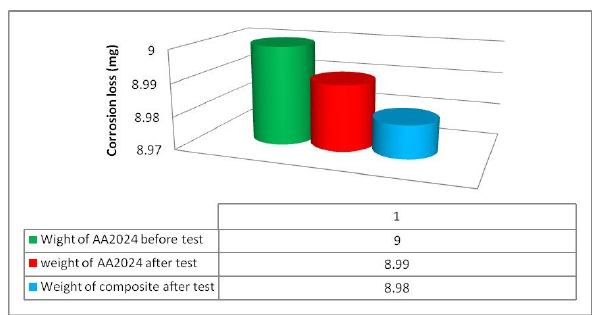
Figure 11: Corrosion behavior of hybrid composite at optimum reinforcement parameters